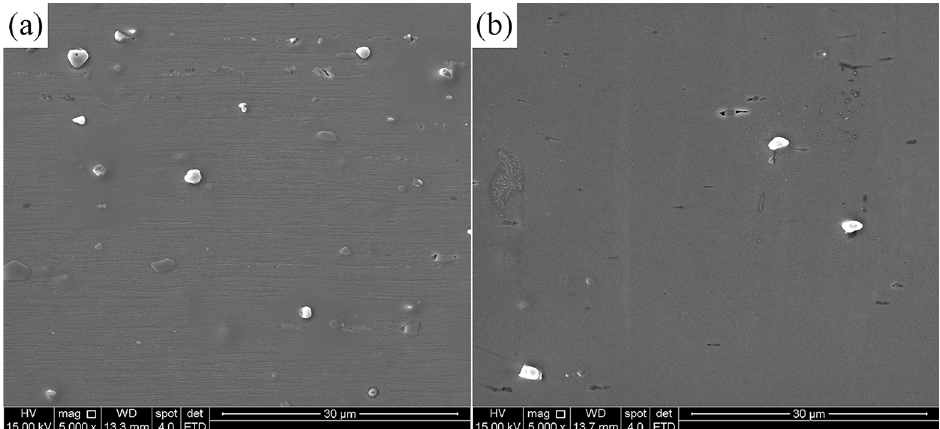
Figure 6. Surface morphologies of NiTi wires after 240 s of electropolishing: (a) superelastic and (b) shape memory.